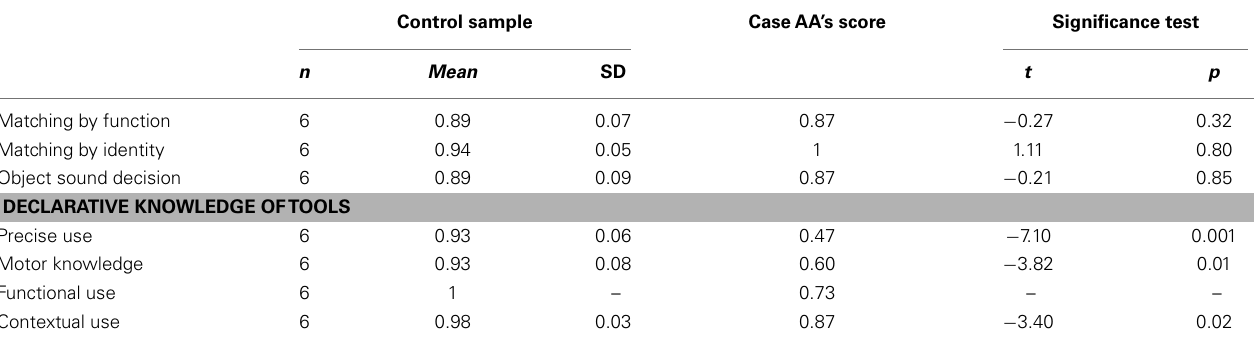
Table 3 |Action-related object